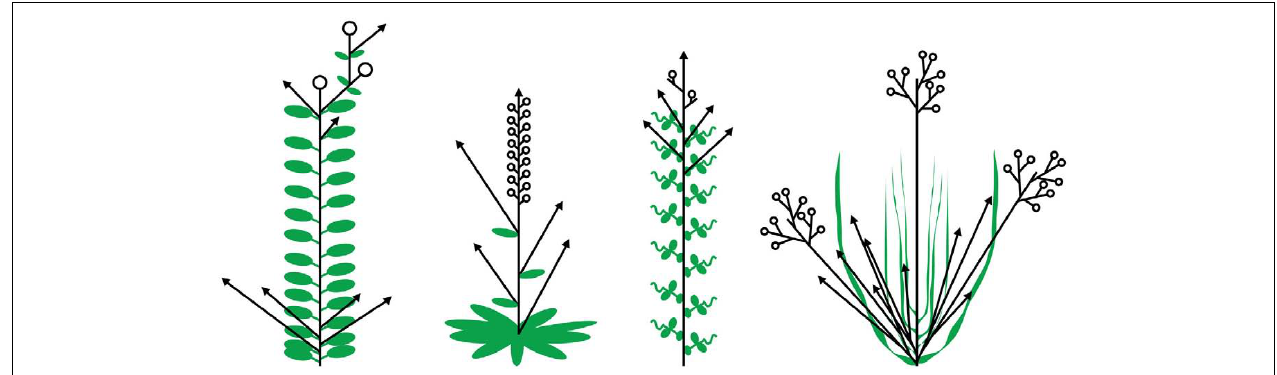
FIGURE 1 | Growth habit of petunia, Arabidopsis , pea, and rice. Branching patterns are shown for (from left to right) petunia, Arabidopsis , pea, and rice. Leaves are shown in green, open circles represent flowers, and arrows represent